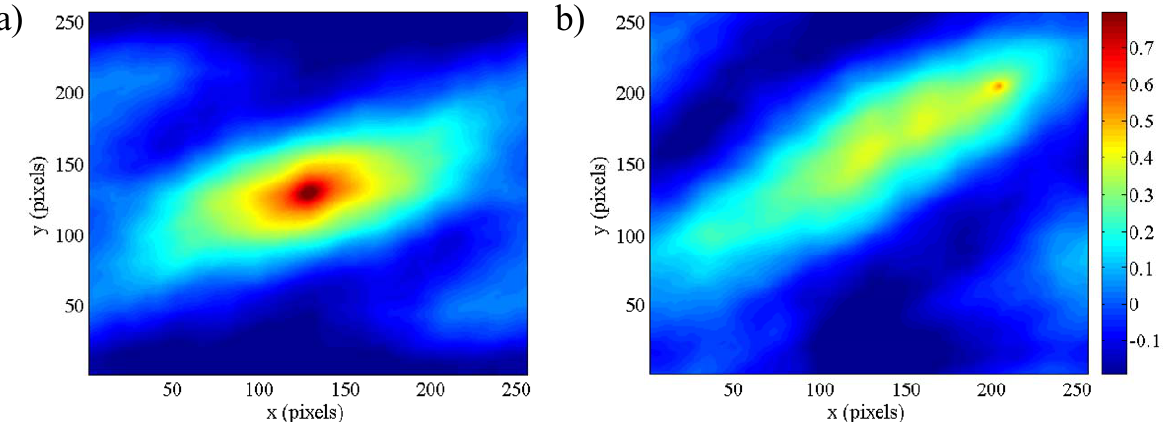
Figure 5. Cross-correlation map for a pair of images with ( a ) 100% and ( b ) 50%